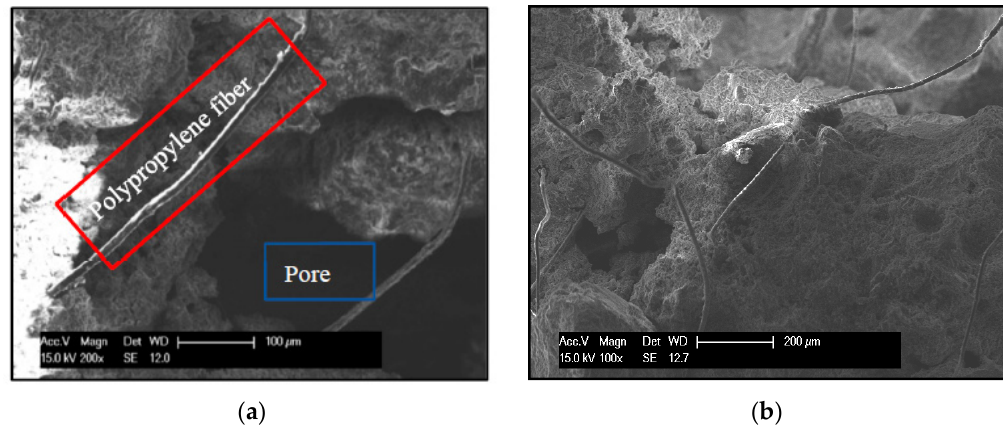
Figure 10. Environmental scanning electron microscope (ESEM) scanning electron microscope sampling: ( a )enlargement of 200 times; ( b )enlargement of 100 times.